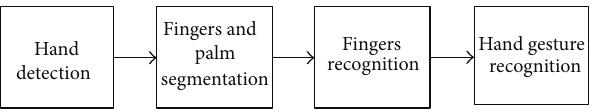
Figure 1: The overview of the proposed method for hand gesture recognition.